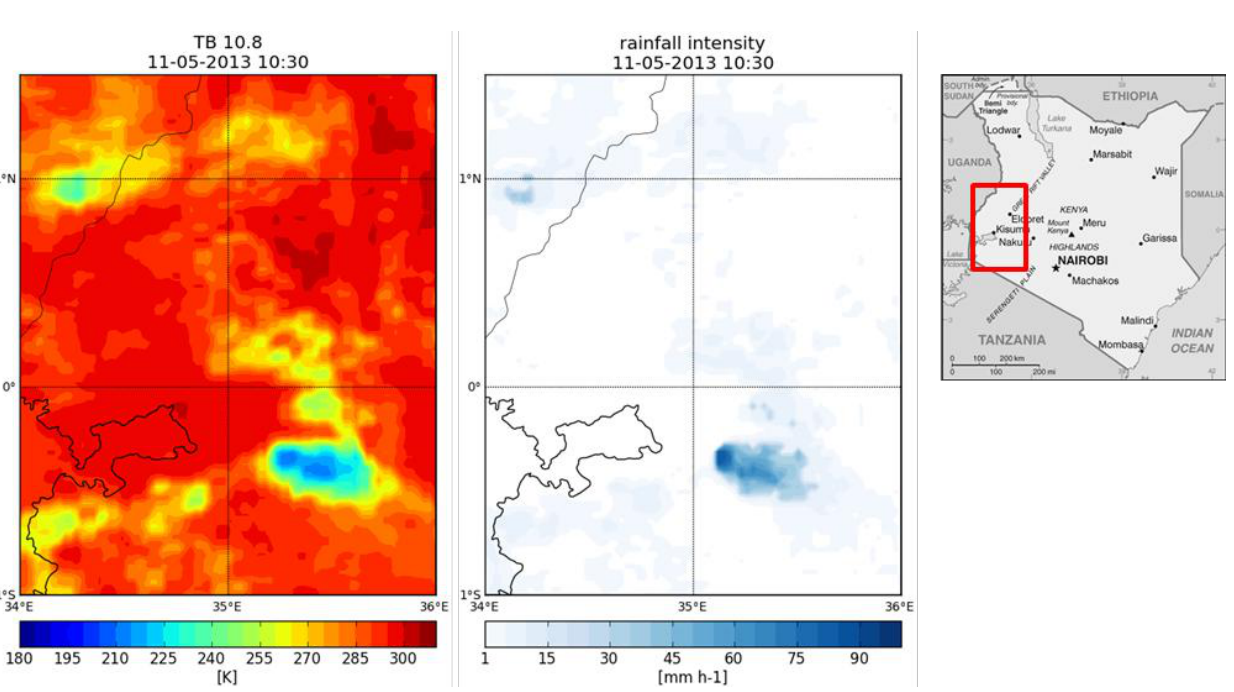
Figure 2. Ten-point-eight micrometer Meteosat Second Generation (MSG) T without parallax correction ( left ) and the modeled rain rate, based on data from six microwave (MW) links and MSG 6.2 µm and 10.8 µm T